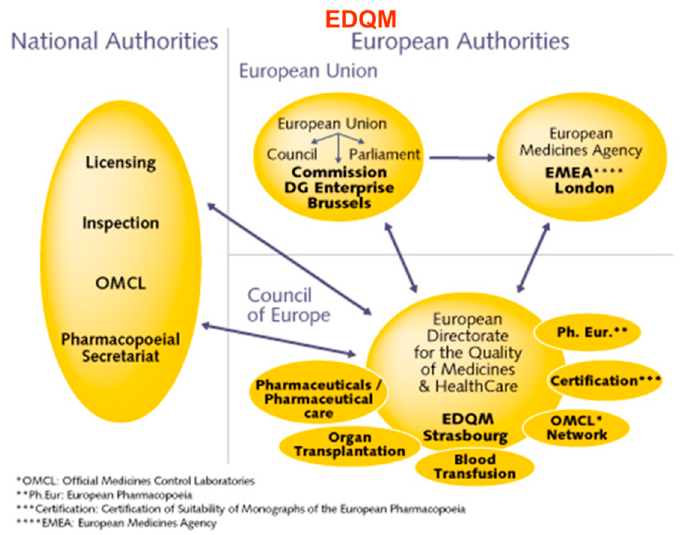
Figure 2. European Union